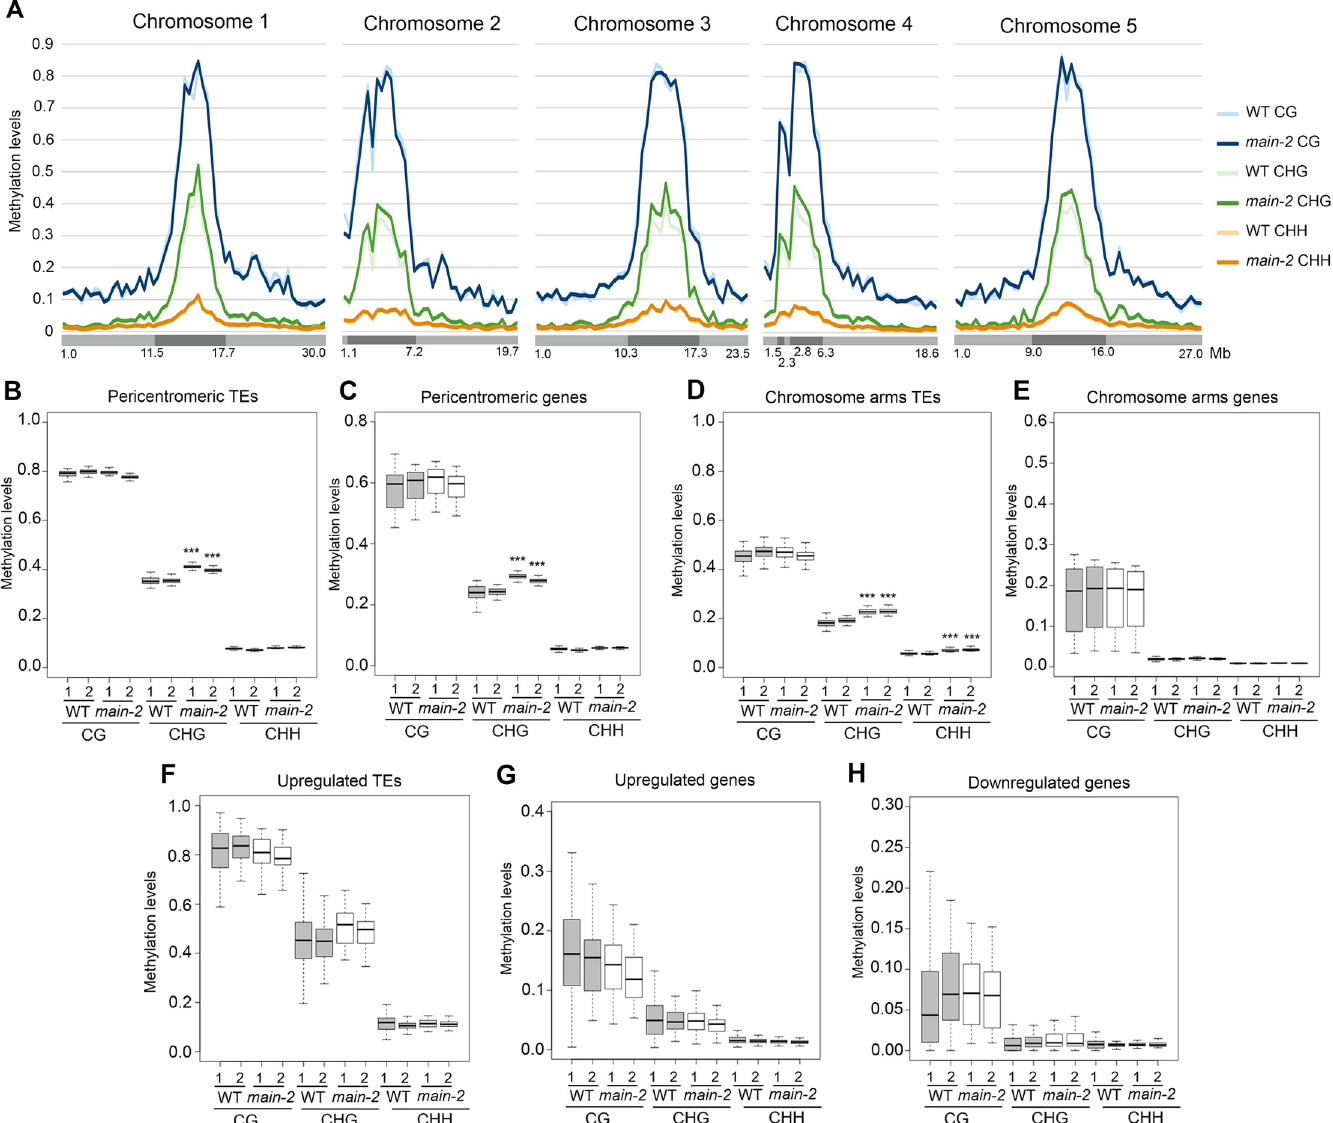
Fig 4. The main-2 mutation has a slight effect on non-CG DNA methylation levels. (A) Genome-wide DNA methylation levels along the five Arabidopsis chromosomes in main-2 versus WT Col plants. Chromosome arms are depicted in light grey, pericentromeric regions in dark grey as defined in [50]. Mb: megabase. (B-H) Boxplot analyses in two main-2 and WT Col biological replicates showing the DNA methylation levels of all pericentromeric TEs (B) and genes (C), all chromosome arms TEs (D) and genes (E), TEs that are upregulated in main-2 (F), and genes that are upregulated (G) and downregulated (H) in main-2 . p-values were calculated using a Wilcoxon test. ��� : p-value <